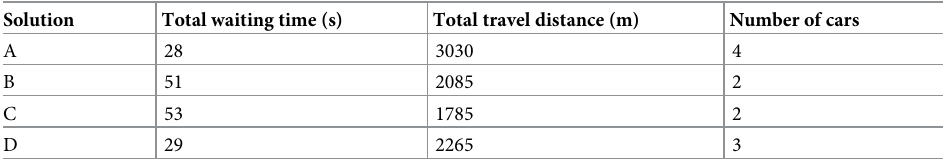
Table 2. Example with 4 requests